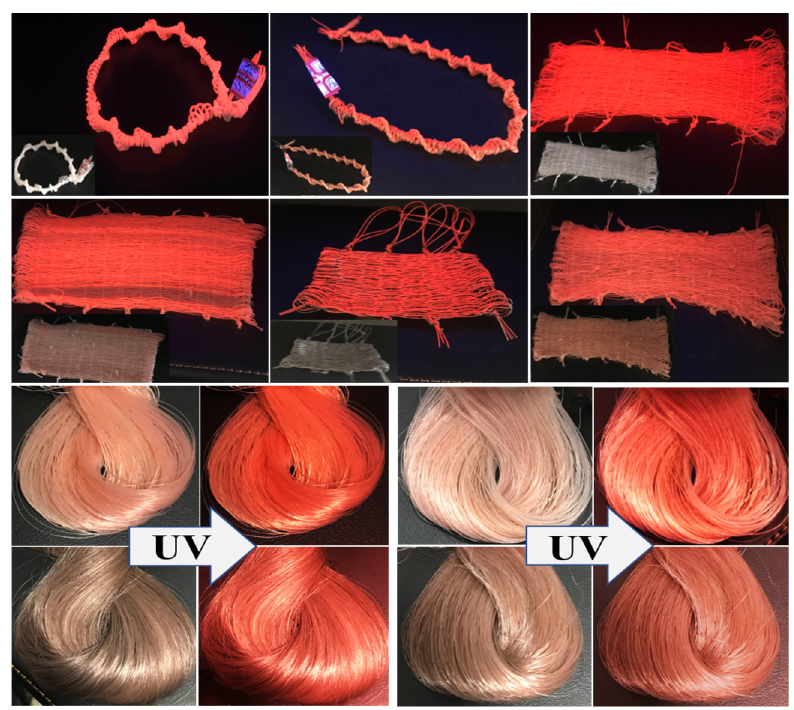
Figure 11. Images of some bright red fabric applications.